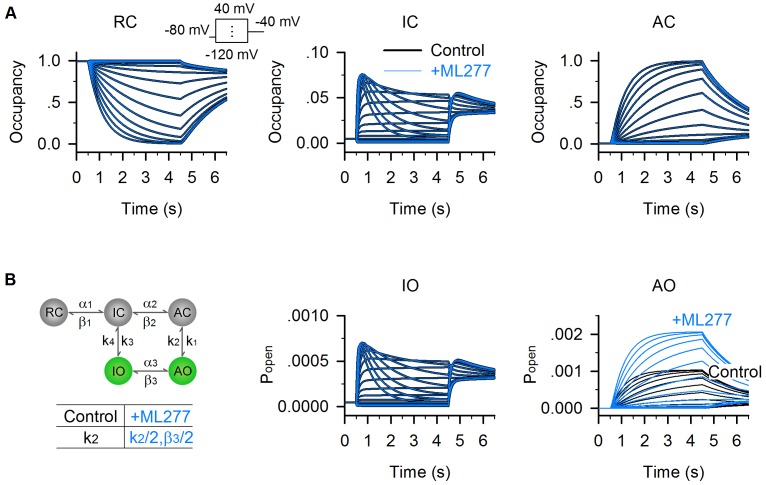
Model simulations of all-state occupancy before and after adding ML277.(A) Model simulations of KCNQ1 all-state occupancy before (black) and after (blue) adding ML277. The voltage protocol was from −120 mV to +40 mV in increment of 10 mV from the −80 mV holding potential, and then stepped to −40 mV. The state occupancies are very similar for RC, IC, AC, and IO states, except for the AO state shows a clear increase after adding ML277. (B) Five-state Markov model. 1/2X K2 and 1/2X β3 can mimic the ML277 effects on KCNQ1 channel.